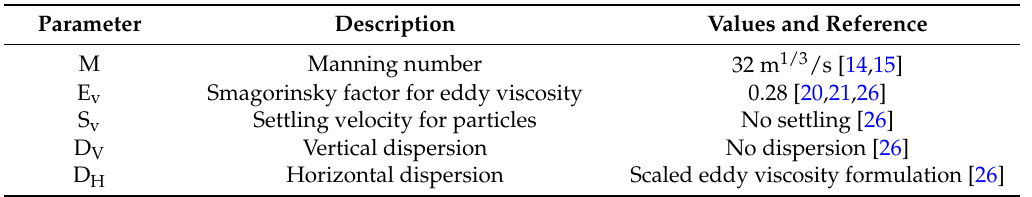
Table 2. Model parameters used for scenario